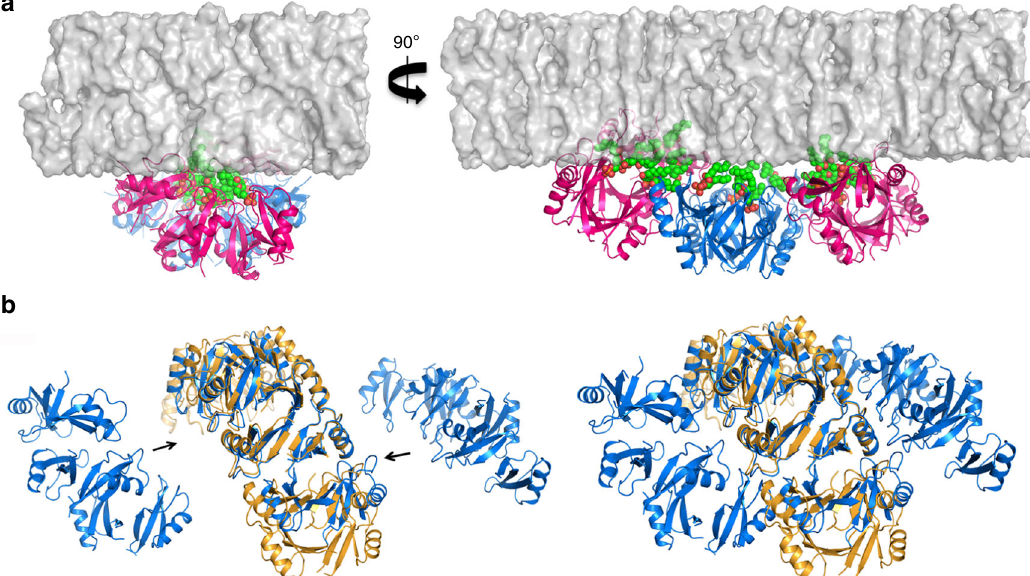
Fig. 8 NaD1 – PA oligomer assembly on a target membrane. a Cartoon representation of the membrane disruption complex (pink and blue), with PA molecules as spheres (red and green), as viewed on a fl at model membrane (surface representation). The curvature of the membrane disruption complex is clearly seen. b Surface representation of the NaD1 – PA complex (blue) aligned with the NaD1 – PIP 2 complex (orange). In the left image, the two smaller arcs have been pulled apart from the central arc to highlight the similarities between the two structures, while in the right image both structures are